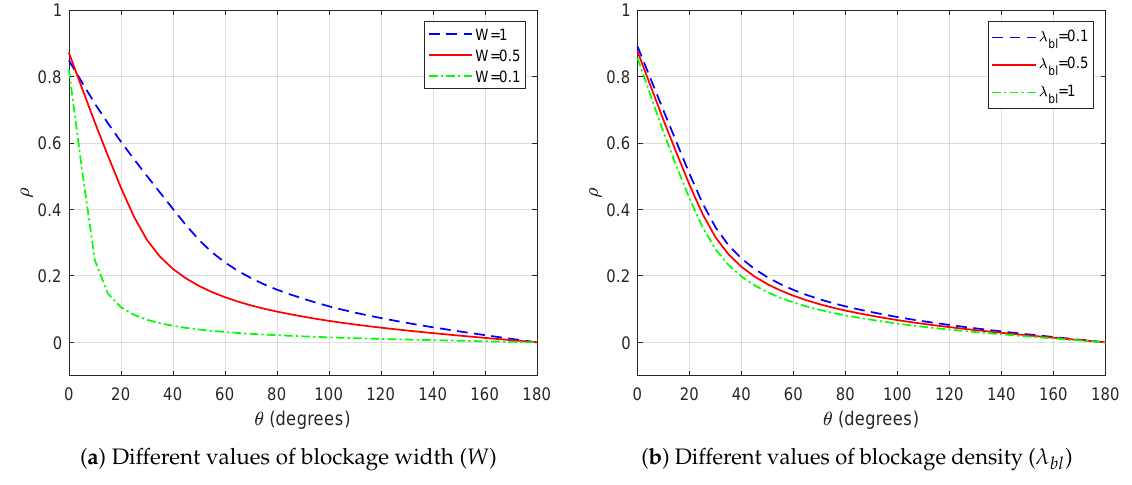
Figure 3. The correlation coefficient ( ρ ) versus the angular separation ( θ ) between X 1 and X 2